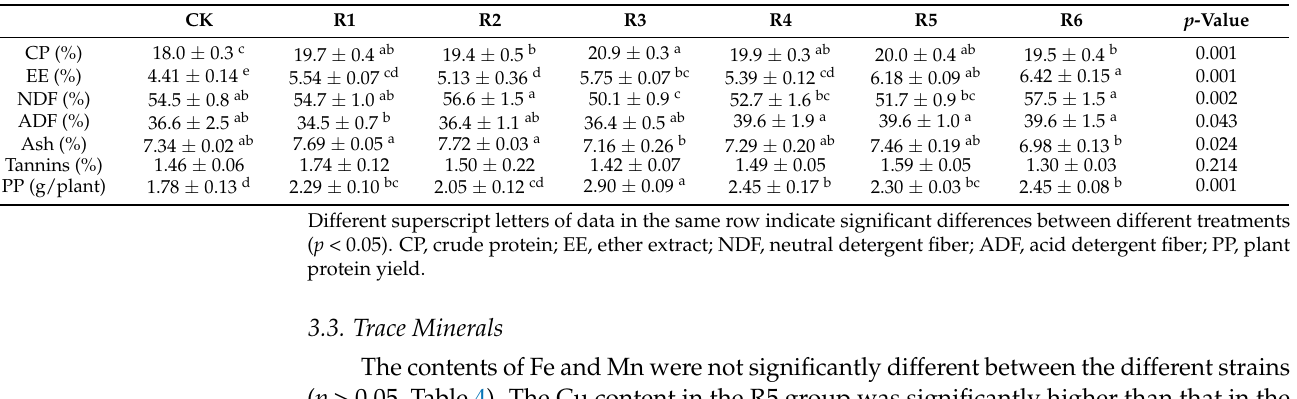
Table 3. Effects of rhizobia inoculation on the nutritional components of D. intortum .